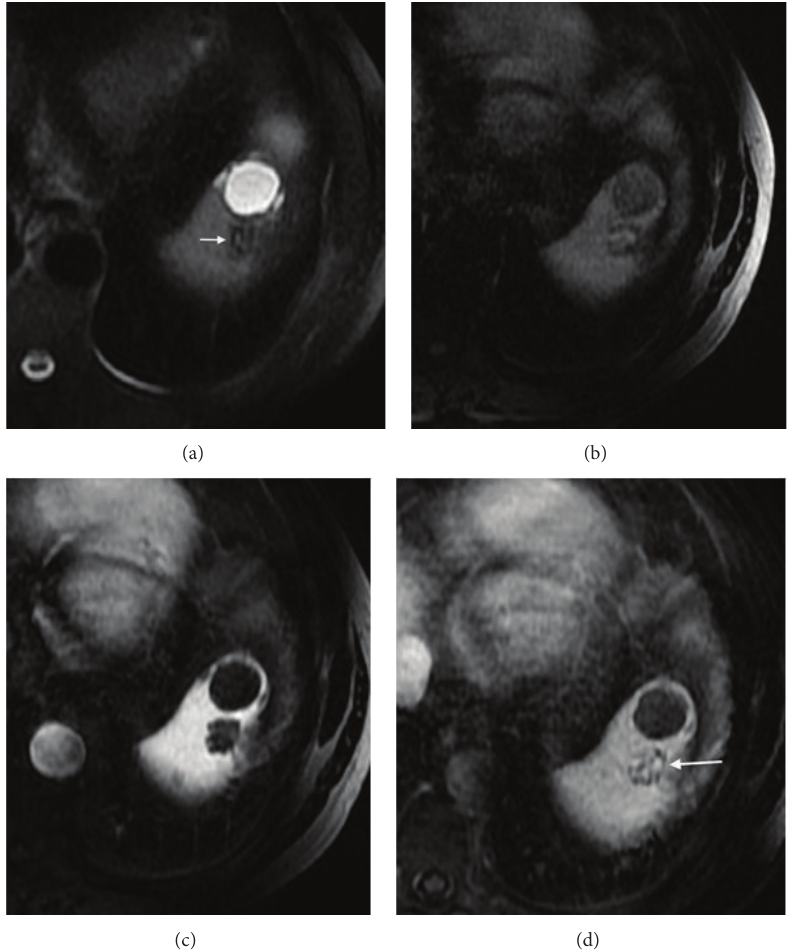
Figure 15: Littoral cell angioma. Axial T2wi FSE with fat suppression (a), pre- (b) and postcontrast axial 3D-GRE T1wi with fat suppression at the venous phase (c) and after 10 minutes of contrast injection (d). A hypointense nodular lesion is depicted on T2wi (arrow, (a)), with areas of magnetic susceptibility artifact, and hypovascular nodules that show subtle peripheral enhancement with progressive slow centripetal accumulation of contrast (arrow, (d)). This mass was thought to represent a sclerosed splenic hemangioma. This heterogeneous splenic appearance is also possible with angiosarcoma and in cases of splenic hemangiomatosis. Note the anteriorly adjacent splenic